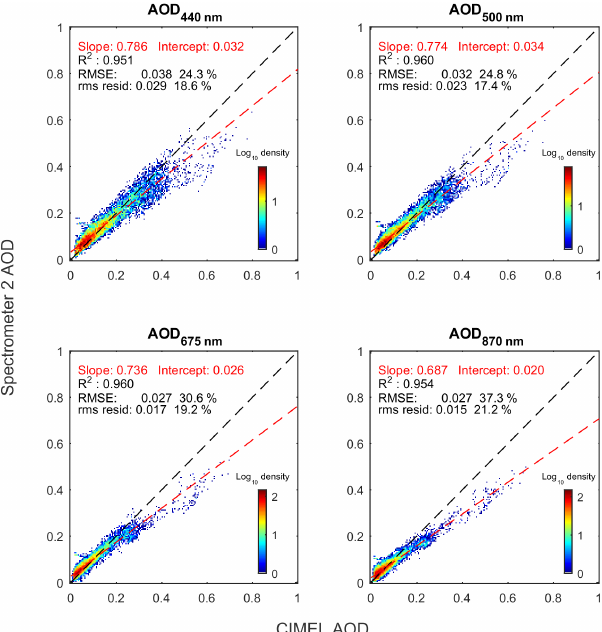
Figure 6. Spectrometer 1 (AS161) AOD results compared with PREDE POM-01 on the roof of Plymouth Marine Laboratory, 14 July–8 September 2014. Spectrometer readings restricted to clear stable periods. These are log density plots: red points represent around 100 data points, whereas the blue points only represent a single data point. No further corrections were applied.